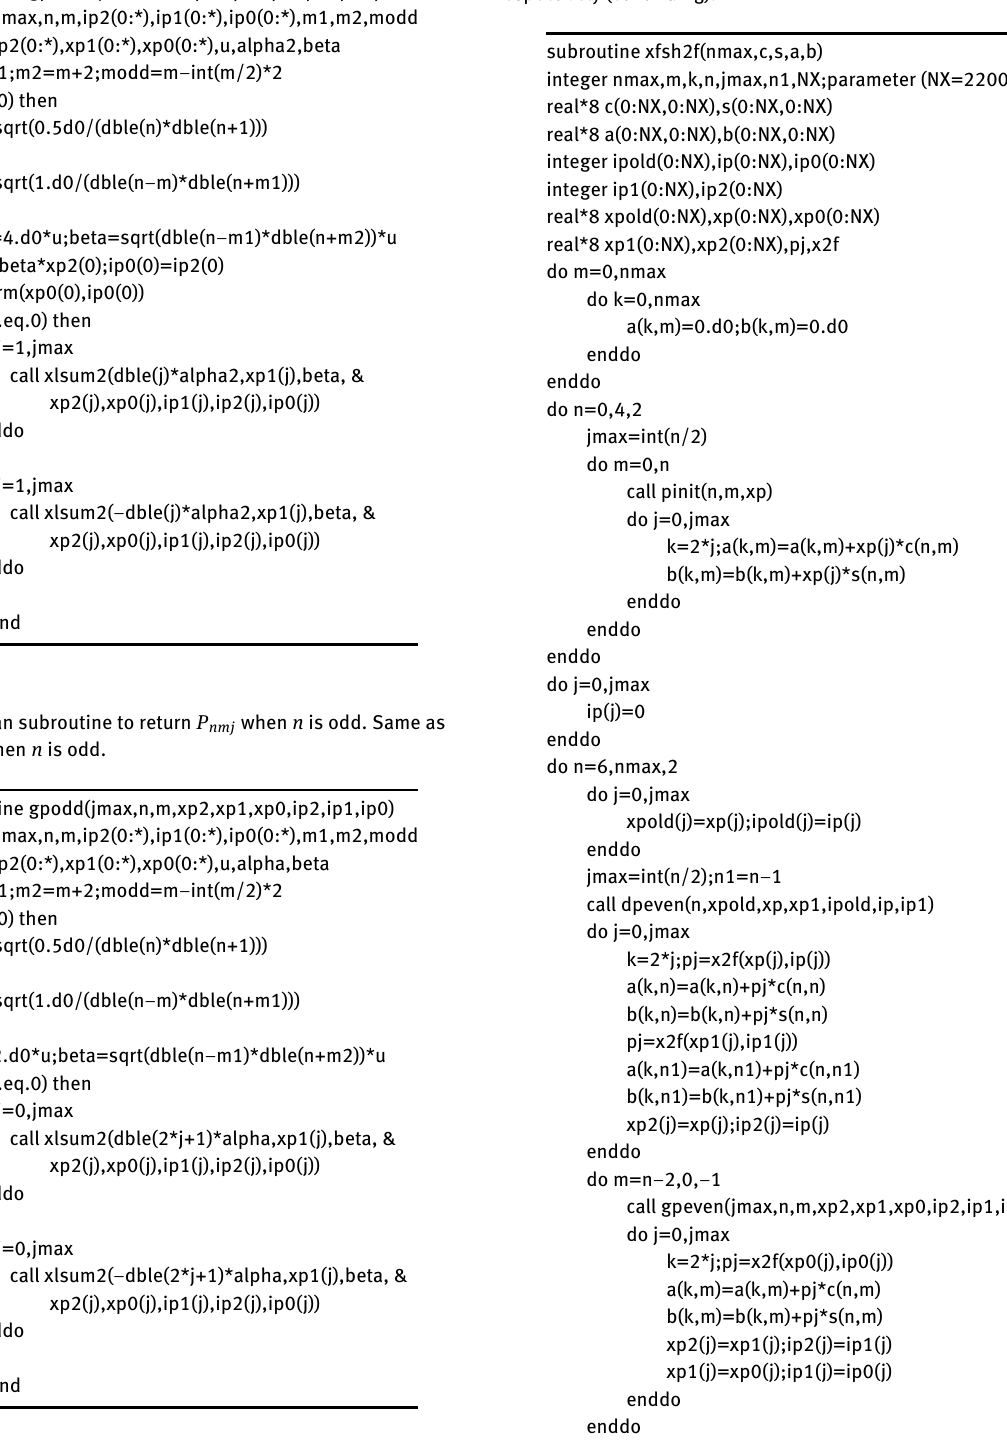
(cid:16) (cid:17) , the 4 π fully C nm , S nm Table 8: Fortran subroutine to transform normalized spherical harmonic coefficients of a given function de- fined on the spherical surface, to ( A km , B km ) , the corresponding Fourier series coefficients of the function. In the program, (i) x2f and xnorm are the Fortran function/subroutine to handle X-numbers (Fukushima, 2012a, tables 6 and 7), and (ii) pinit , dpeven , dpodd , gpeven , and gpodd are the Fortran subroutines listed in Tables 3–7, respectively